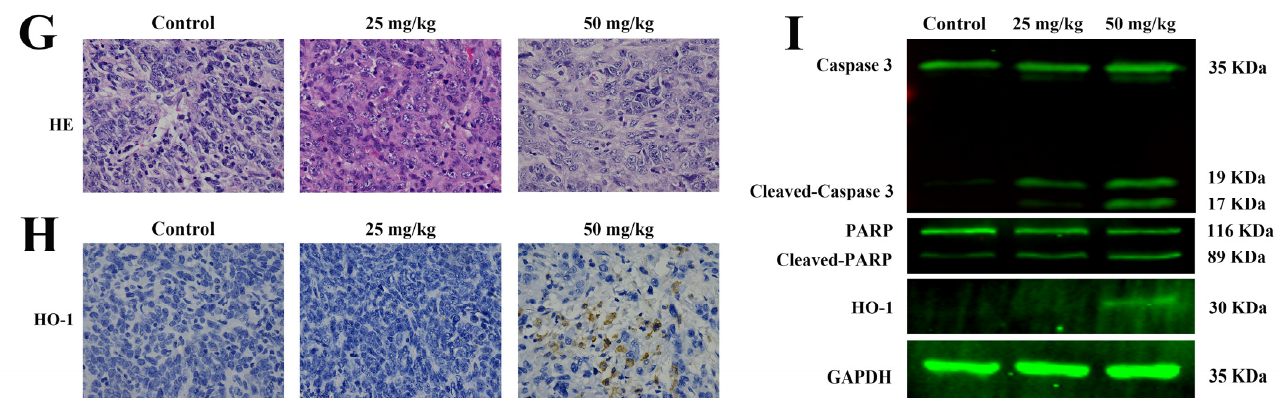
Figure 8. HCL-23 inhibits breast tumor growth in vivo. Mouse breast cancer 4T1-Luc cells were orthotopically injected into female BALB/c mice and treated with HCL-23 (50 mg/kg and 25 mg/kg) (n = 4/group). ( A ) Representative images of tumors formed in mice were visualized by a live imaging system. ( B ) The images of tumors at the endpoint of the experiment. ( C ) Tumor weight from different groups. ( D ) Tumor inhibition rate (%). ( E ) Tumor growth curve. ( F ) Mice body weight curve. ( G ) Representative images of HE staining (magnification, ×400). ( H ) Representative images of IHC staining for HO-1 (magnification, ×400). ( I ) The expression levels of Caspase 3, Cleaved-Caspase 3, PARP, Cleaved-PARP, and HO-1 in tumor tissues were measured by Western blot. Data represent the mean ± SD. * p < 0.05, ** p < 0.01 vs. the control group.